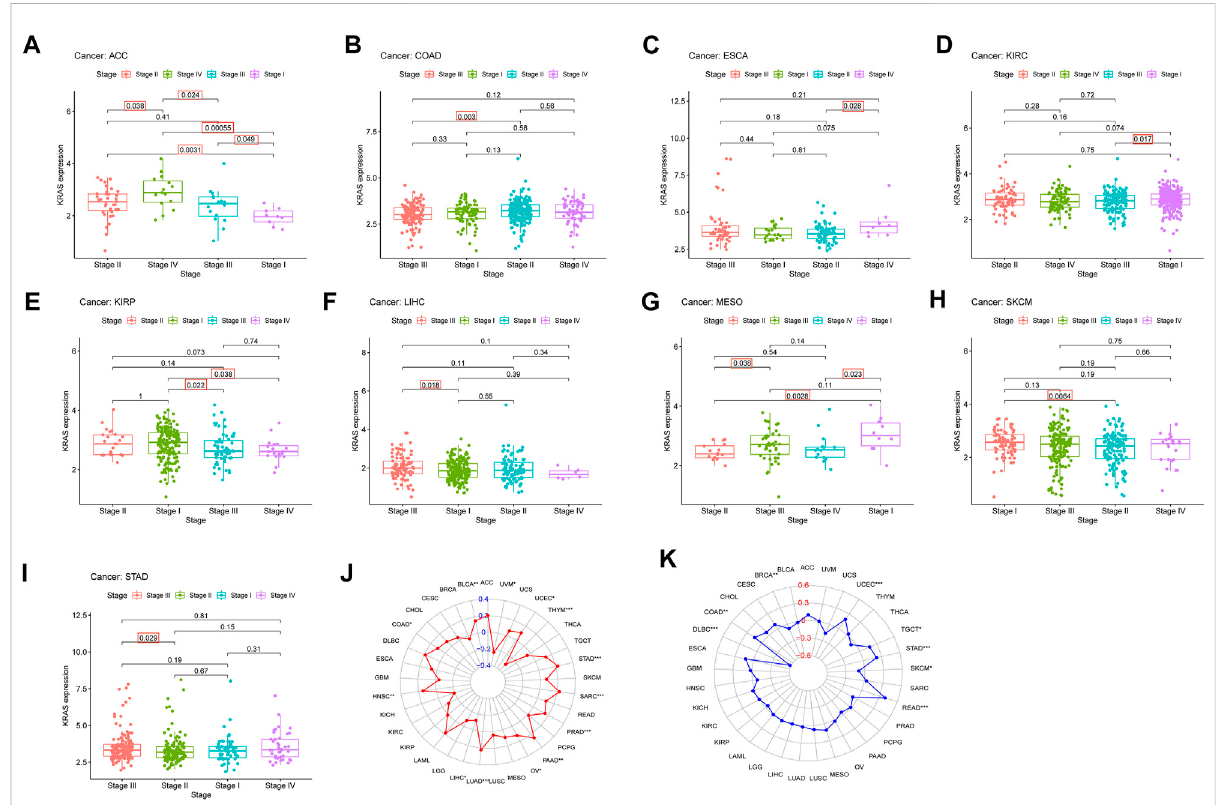
FIGURE 3 The relationship between KRAS expression level and pathological characteristics of tumor patients. (tumor mutation burden, microsatellite instabilitiy). (A – I) Relationship of KRAS expression level and stage grade. (J) Tumor mutation burden (TMB). (K) Microsatellite instability (MSI). * p < 0.05. ** p < 0.01, *** p <